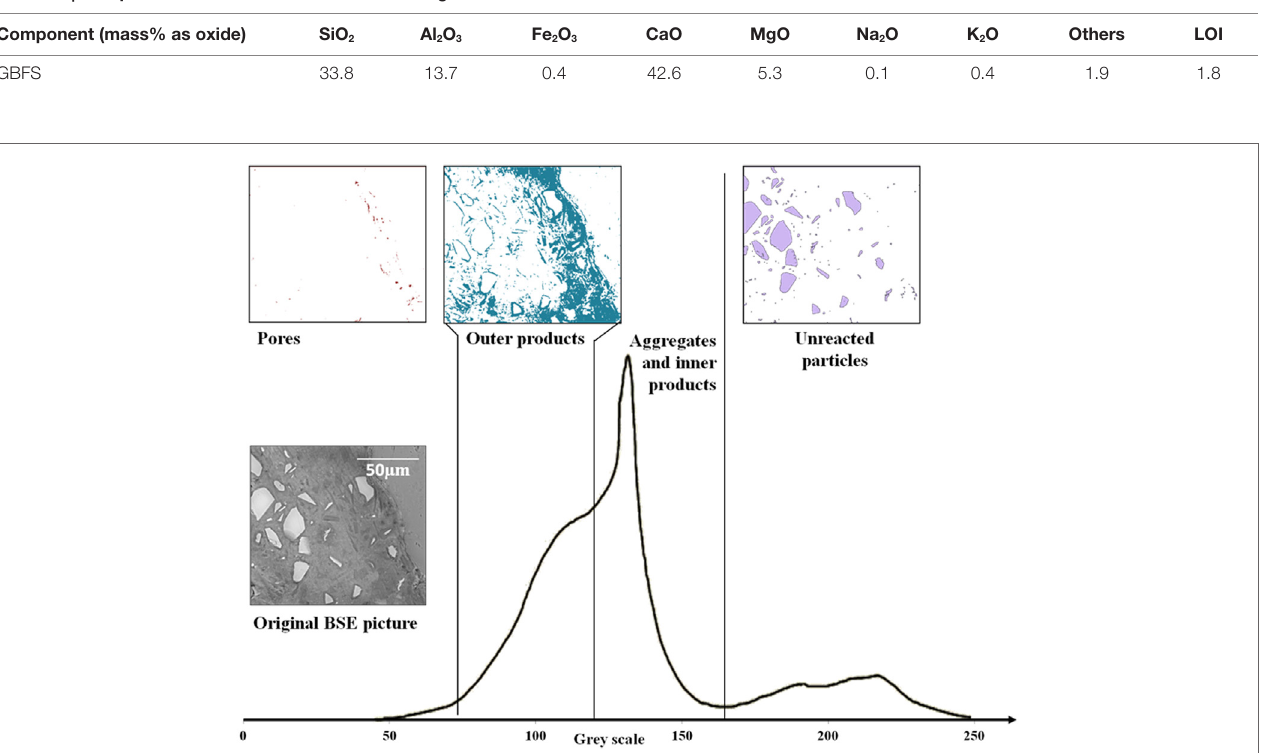
TaBle 1 | composition of gBFs used. lOi is loss on ignition at 1000°c.